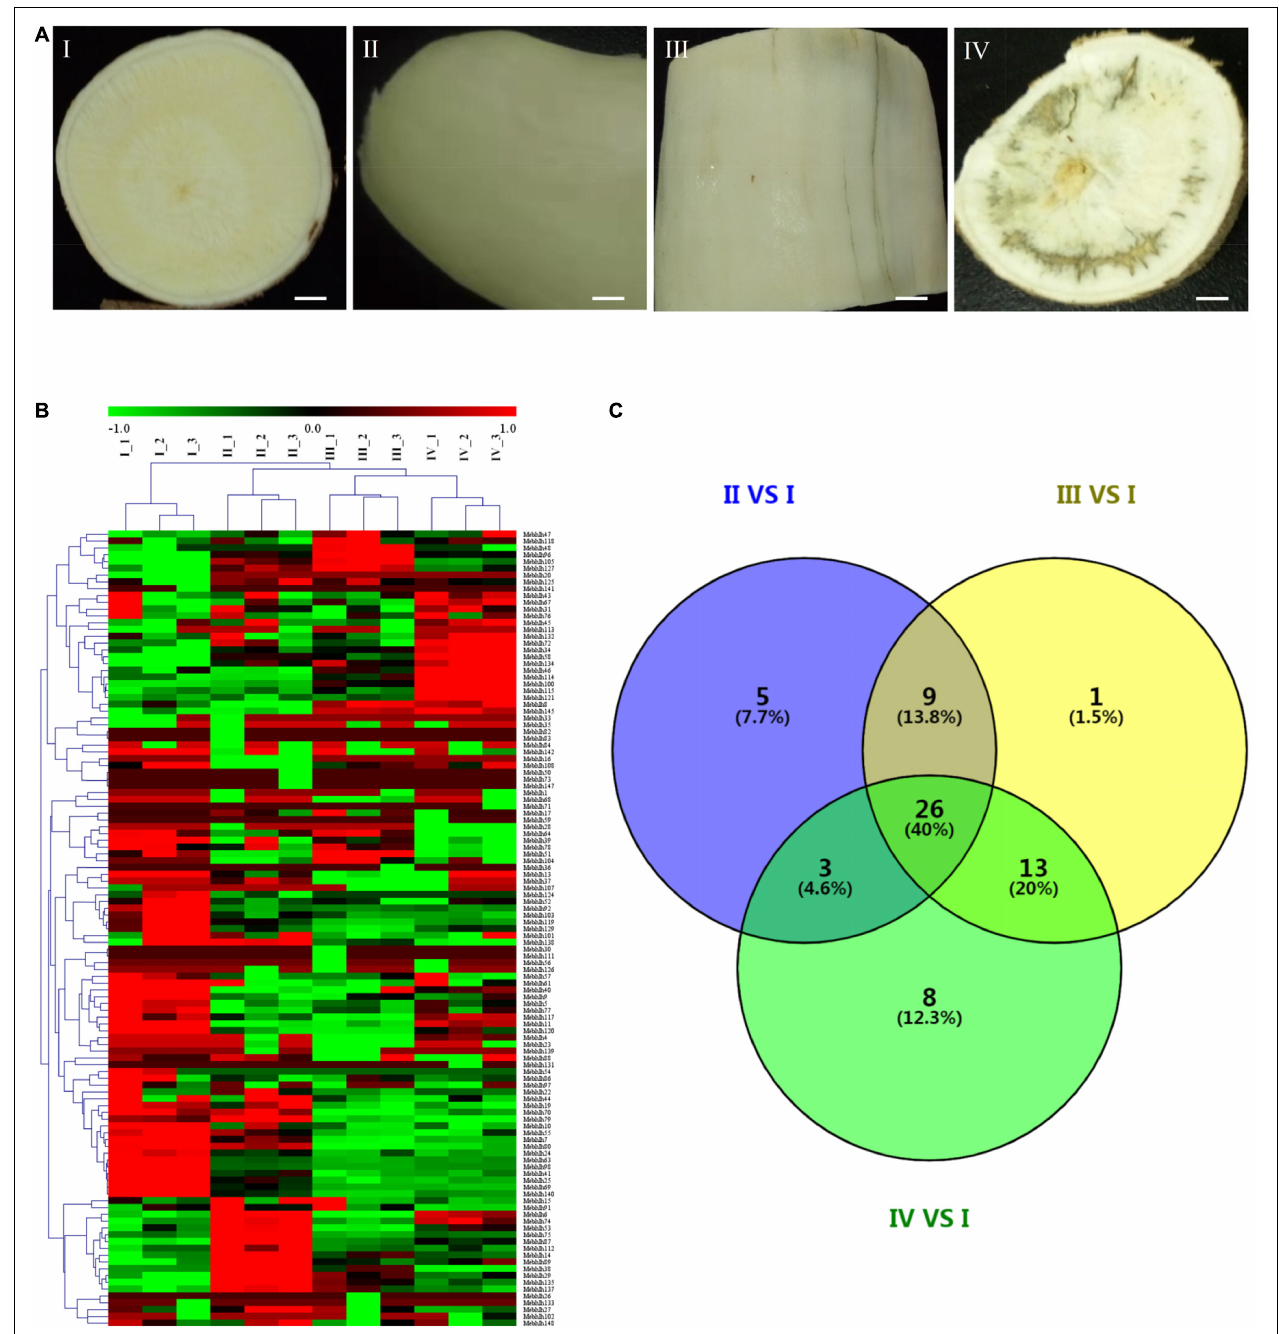
FIGURE 6 | Expression profiles of MebHLH genes in tuberous roots during PPD process. (A) Different PPD degree samples collected from SC9 tuberous roots was classified into 4 levels. I, PPD score was 0, II, PPD score was 3.2%, III, PPD score was 10.6%, IV, PPD score was 32.5%. Bars = 5 mm. (B) The heat map was generated by Mev software. The expression data were gene-wise normalized and hierarchically clustered with average linkage. The bar on the right of the heat map indicates relative expression values. Values 1, 0, -1 represent high, intermediated, and low expression, respectively. (C) Venn diagram of differential expression MebHLHs in three comparison pairs. The sample with 0 PPD score was used as